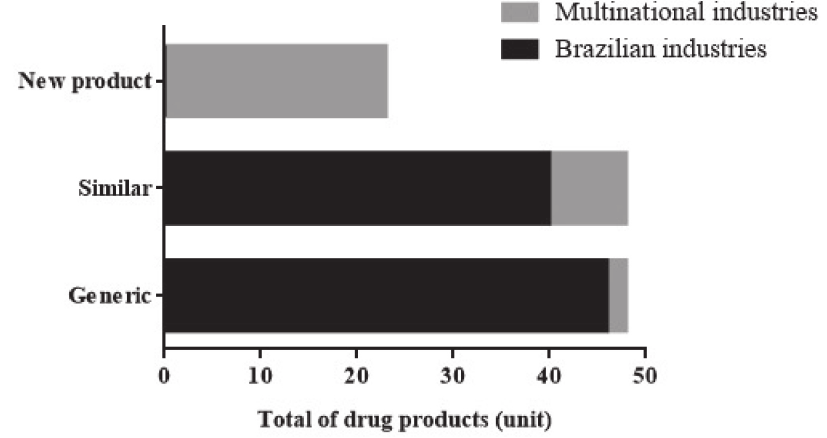
FIGURE 3 - Composition of Brazilian market for ophthalmic